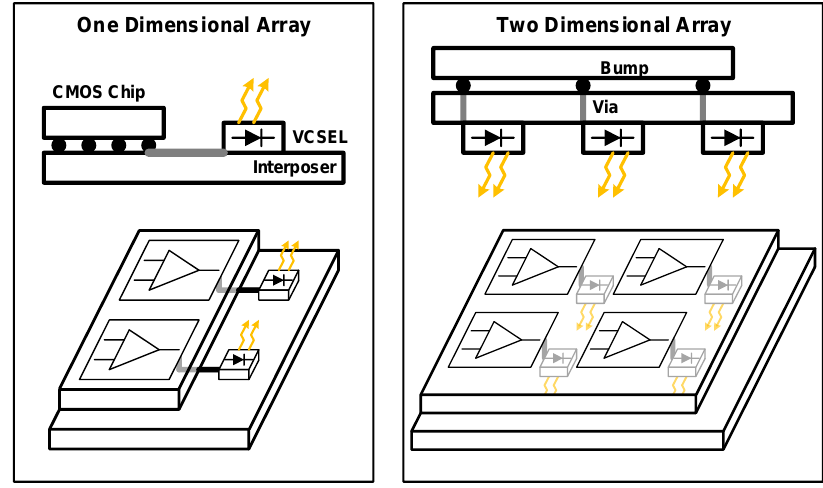
Figure 15. Implementation of 2-D array of EPIC [55].